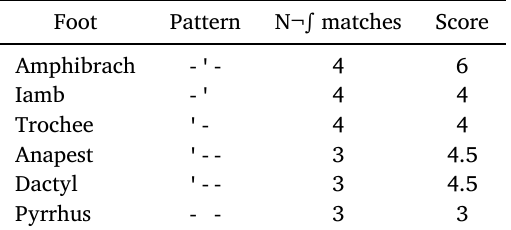
Hypothetical feet for the